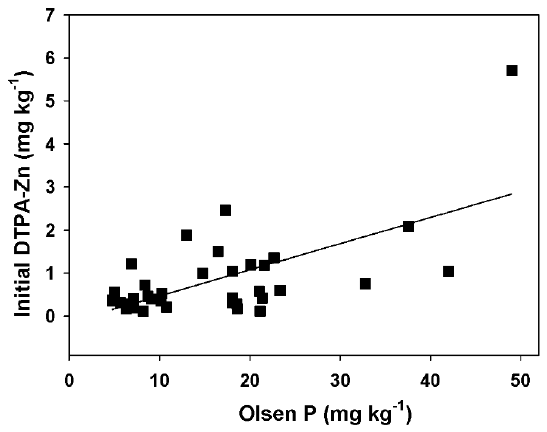
Figure 3. Relationship between the initial DTPA extractable Zn (mg kg − 1 ) and the Olsen P (mg kg − 1 ) in soils. Y = − 0.13 + 0.06 X; R 2 = 0.41; p < 0.0001. Regression for transformed variables to meet normality criteria is: Ln Y = − 2.47 + 0.73 Ln X; R 2 = 0.25; p < 0.01.